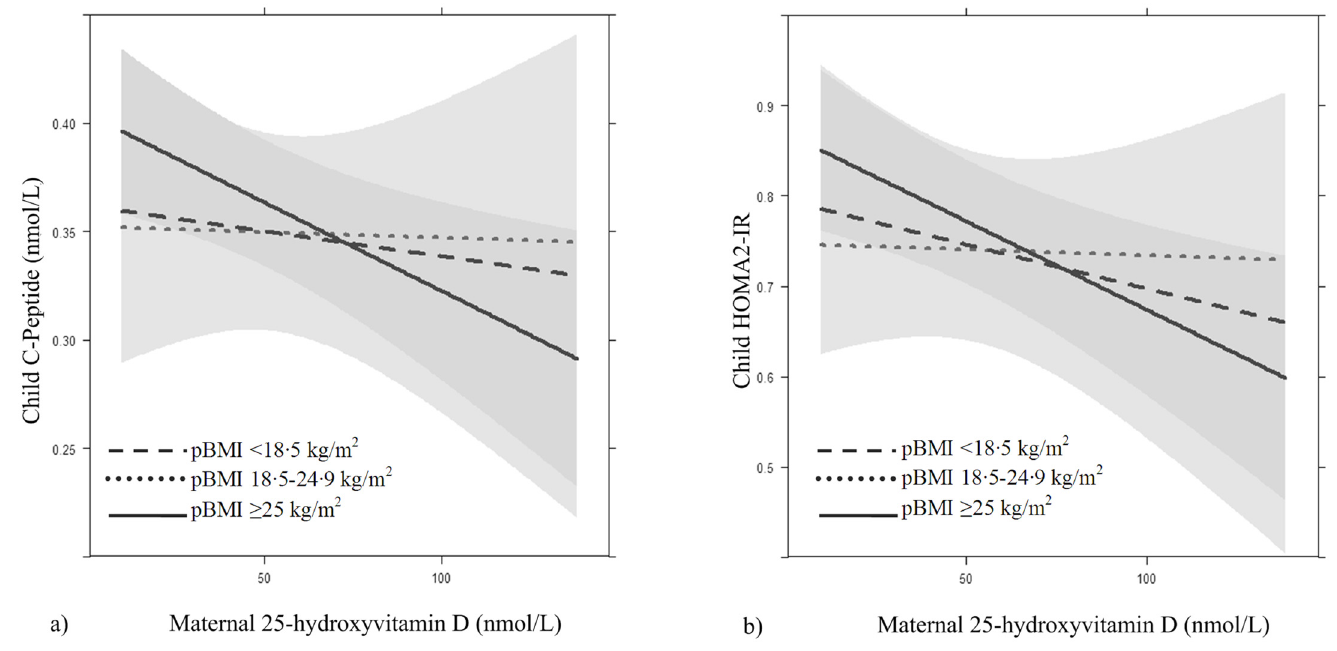
Fig 3. The association between maternal 25-hydroxyvitamin D concentration and insulin resistance markers in young children. The association between maternal 25-hydroxyvitamin D concentration in early pregnancy and a) C-peptide and b) HOMA2-IR in 5 – 6 year old children with interaction with pre-pregnancy BMI presented. Adjusted for maternal age (32.4 years), maternal education (10 years), child age (5.6 years) and sedentary time (1.4 hours), and presented for Dutch ethnicity, nulliparous mothers, non-smokers, male children, no use of vitamin D or A/D drops in infancy and no history of